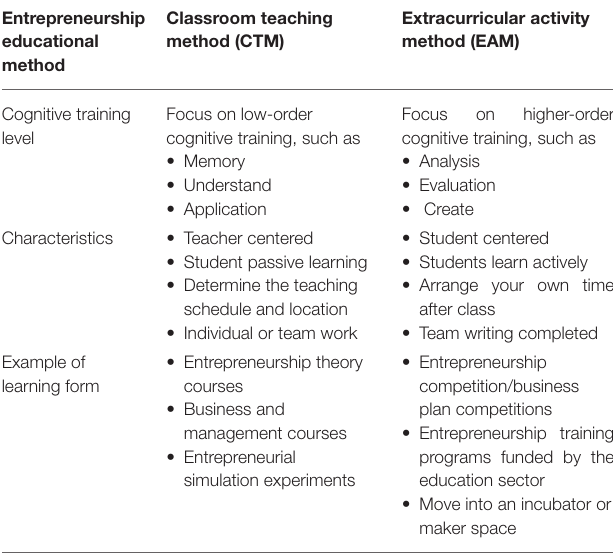
TABLE 1 | Classification of entrepreneurship educational